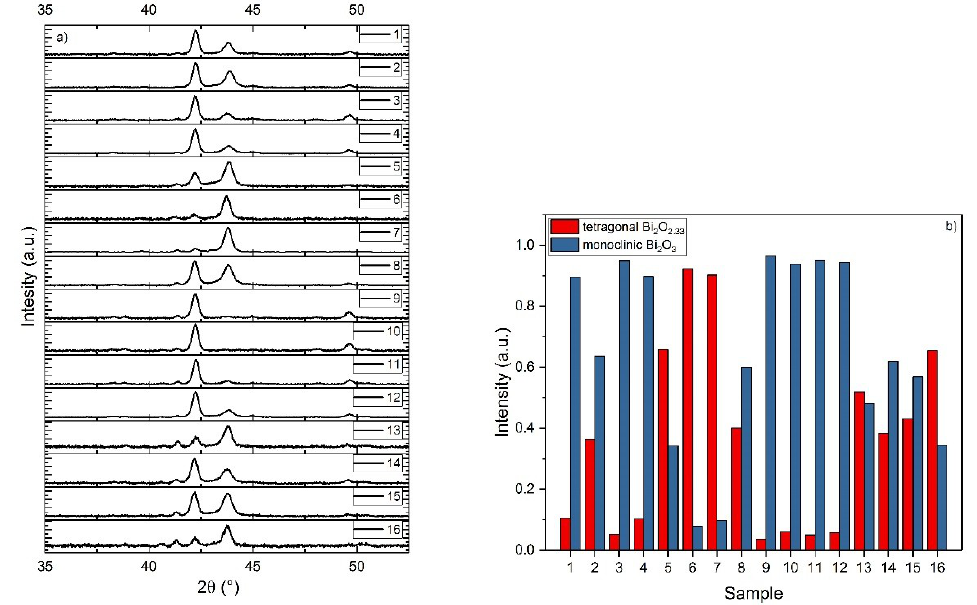
Figure 2. ( a ) Normalized XRD plot of parameter set and ( b ) phase fraction of layers with tetragonal non-stoichiometric Bi 2 O 2.33 and monoclinic Bi 2 O 3 .